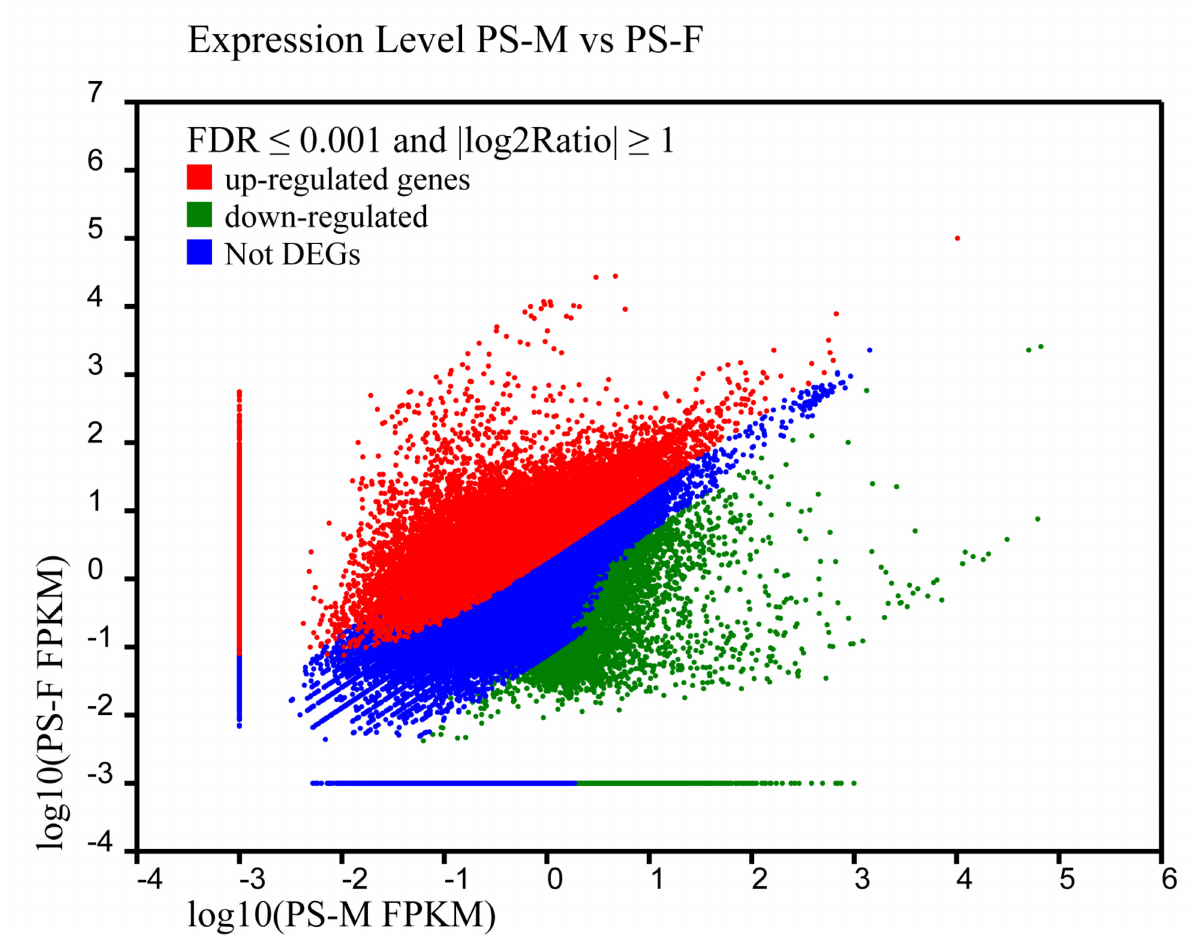
Figure 1. The genes were classified into three classes. Blue genes are not differentially expressed genes. Green genes are down-regulated that gene expression of left sample is larger than right sample. Red genes are up-regulated that gene expression of right sample is larger than left sample. The horizontal coordinate is the expression level of PS-M and the vertical coordinates is the expression level of PS-F. PS-M represents the male Portunus sanguinolentus and PS-F represents female Portunus sanguinolentus . n = 4 for each